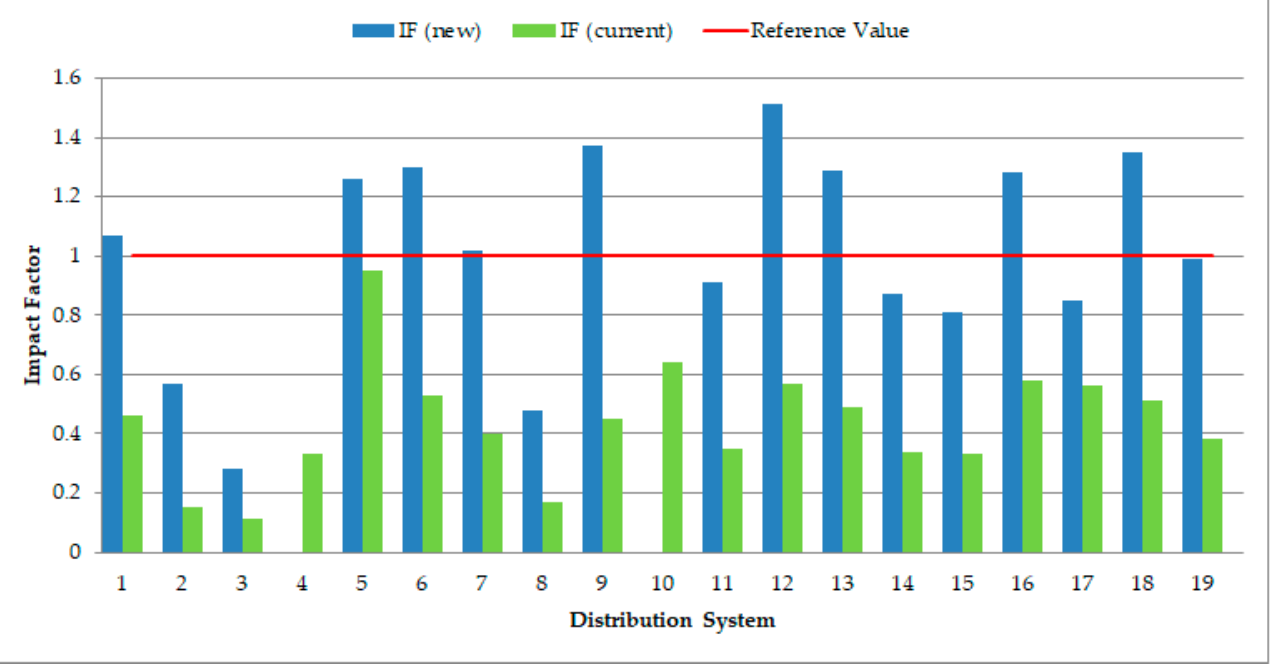
Figure 3. Comparison of the new and current IF with the reference value.